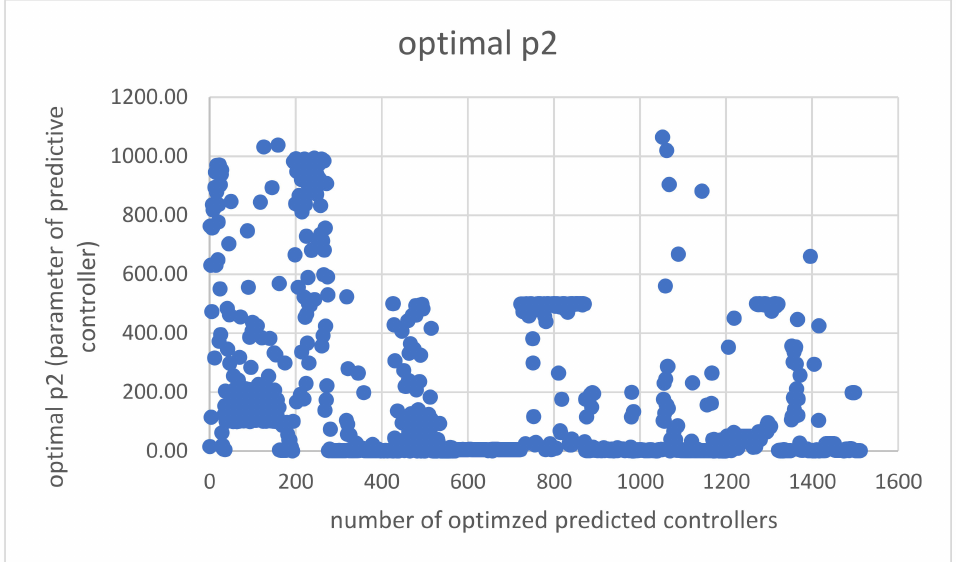
Figure 13. Optimal controller parameter p2 of predictive controller (Supplementary Materials).